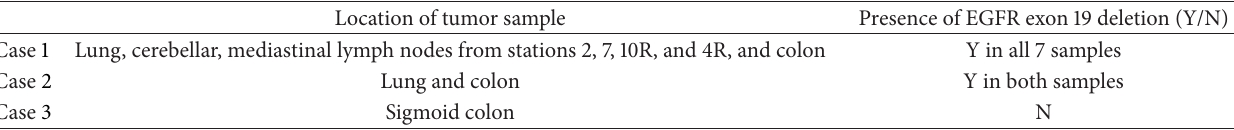
Table 1: Analysis of tumor